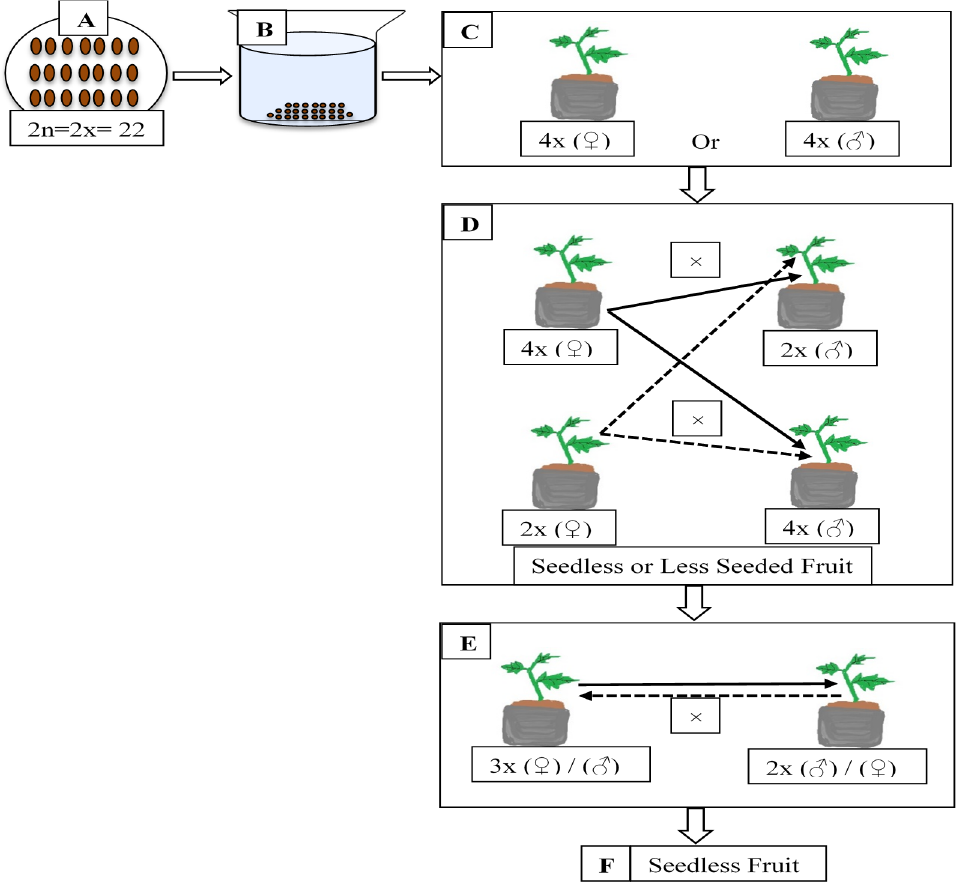
Figure 2. Hypothetical pathways of polyploidization and triploid breeding for seedless fruit production in pointed gourd ( Trichosanthes dioica Roxb.). ( A ) Mature seeds of diploids (2n = 2x = 22), ( B ) colchicine treatment on seeds, and ( C ) tetraploid induction for either female or male as dioecious and represented by 4x ( ♀ ) and 4x ( ♂ ), respectively; ( D ) tetraploid female 4x ( ♀ ) pollinated with diploid 2x ( ♂ ) and tetraploid 4x ( ♂ ) males, indicated by straight lines; and diploid females 2x ( ♀ ) pollinated with tetraploid 4x ( ♂ ) and diploid 2x ( ♂ ) males, indicated by dash lines. ( E ) If viable seeds are produced by crossing with the tetraploid parents (female or male), then the F1 progenies will be triploid (3x). The generated triploid female 3x ( ♀ ) will be pollinated by a diploid pollinizer 2x ( ♂ ) (straight arrow), and a reciprocal cross (dash arrow) will also be performed. ( F ) The developed fruits will then be seedless.